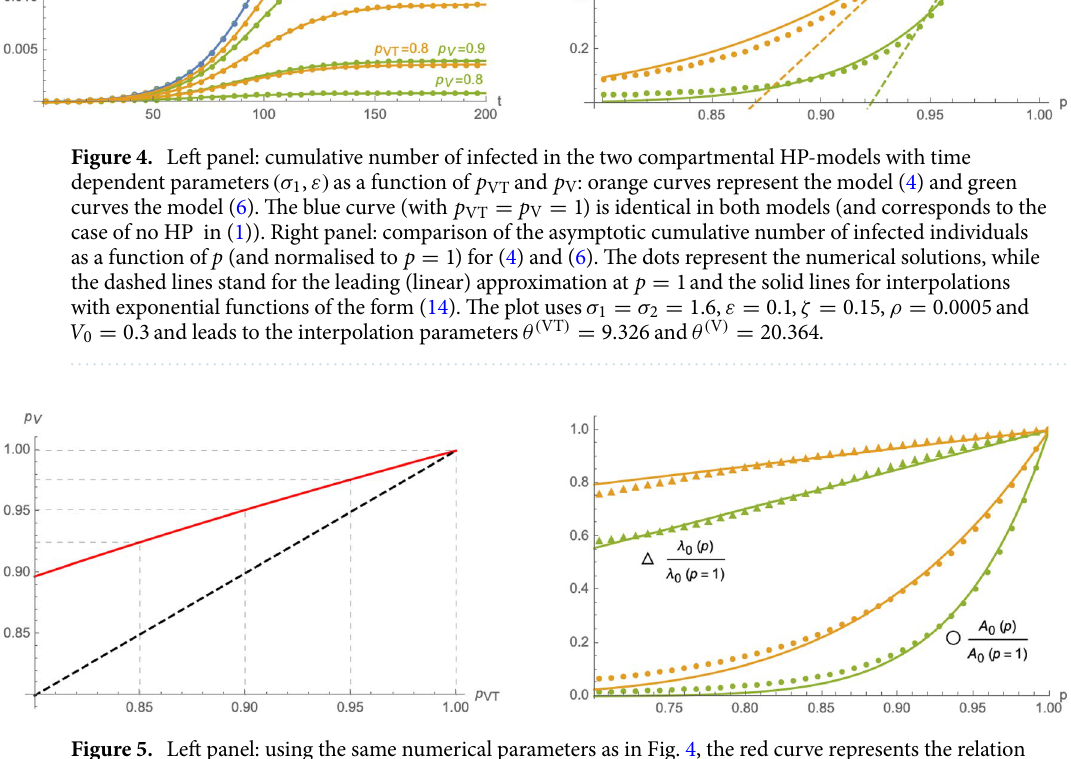
Figure 5. Left panel: using the same numerical parameters as in Fig. 4, the red curve represents the relation between the p -parameters of (4) and (6) that lead to the same asymptotic cumulative number of infected individuals. The dashed black line represents for comparison the relation p V = p VT . Right panel: p -dependence of the parameters ( A 0 , (cid:31) 0 ) relative to the case p = 1 in the eRG approach equivalent to the SIIRV model with ( p ) time dependent rates: circles represent numerical values of A 0 A 0 ( p = 1 ) while triangles represent numerical values of (cid:31) 0 ( p ) (cid:31) 0 ( p = 1 ) , with orange symbols computed using the model (4) and green symbols correspond to the model (4). The solid lines represent interpolations of the numerical solutions with an exponential function of the form (16) for (cid:31) 0 ( p ) A 0 ( p ) = 0.025 , (cid:31) = 0.06 (at t = 0 ), t = 100 , V = 0.3 and 0 0 0 (cid:31) 0 ( p = 1 ) . The plots use A 0 A 0 ( p = 1 ) and a linear function for ζ = 0.15